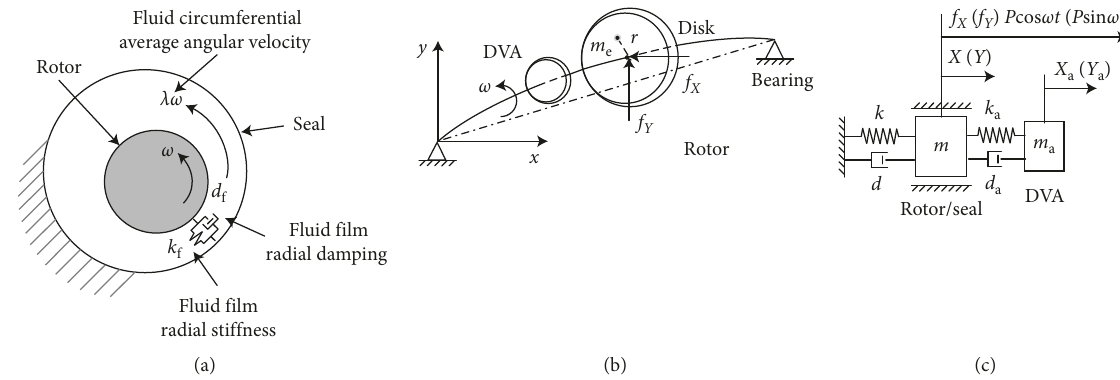
Figure 2: The model of the rotor/seal system with the DVA. (a) The nonlinear seal force model. (b) The rotor/seal system with the DVA. (c) The equivalent